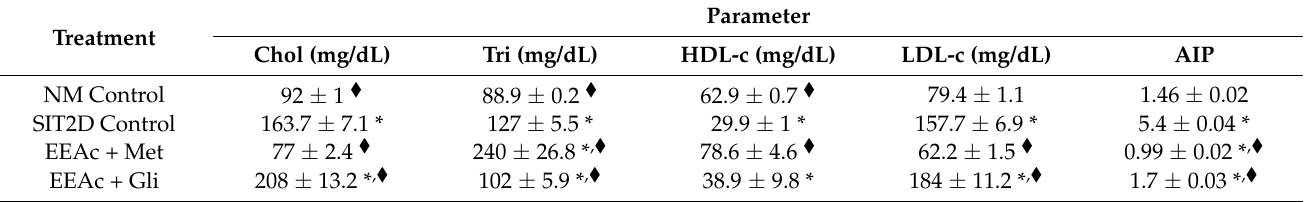
Table 3. Lipid profile values of groups treated with oral antidiabetic drugs in combination with EEAc. Parameter Treatment